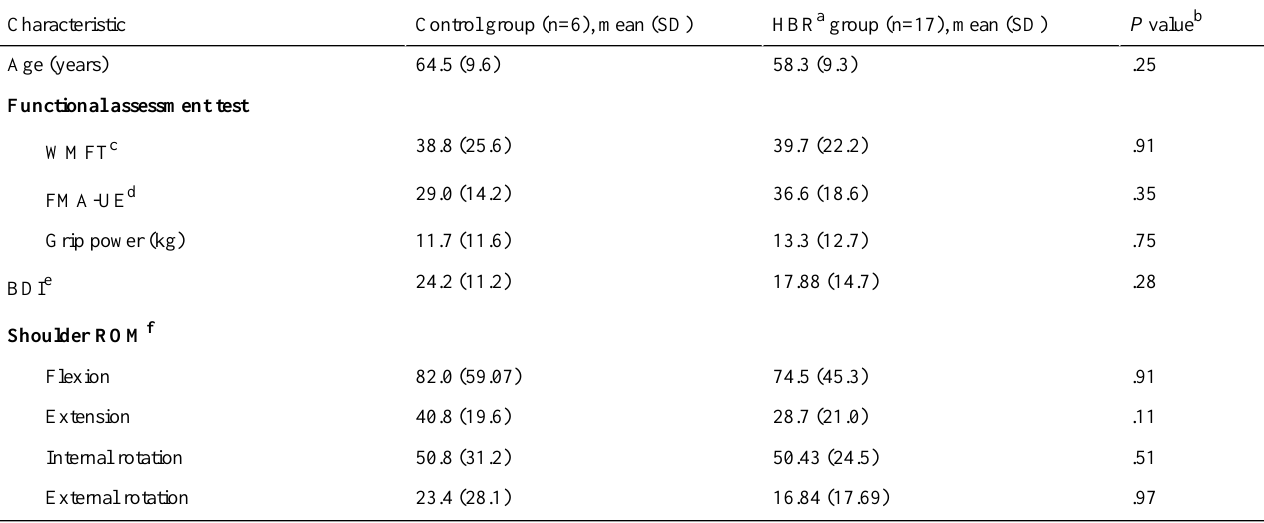
Table 2. Patient demographics and baseline assessment in the control and home-based rehabilitation